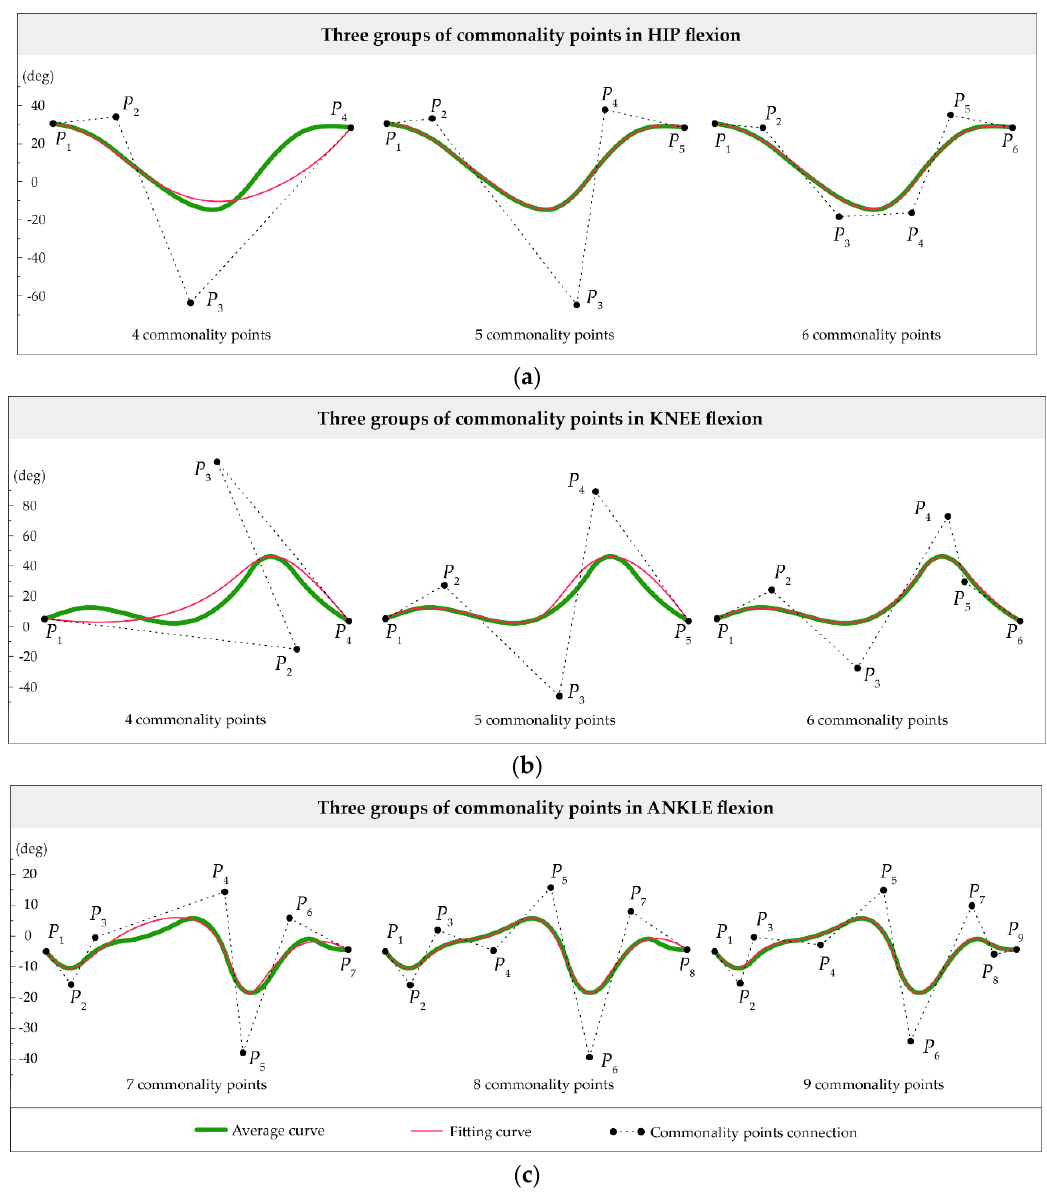
Figure 5. The fitting curves of three groups of commonality points to each joint: ( a ) The average curve (dark green line) of the hip was fitted through four, five, and six commonality points, respectively. The fitting curve (red line) at five points had the similar matching effect as six points, but with fewer points; ( b ) The three relationships among the fitting and average curves at four, five, and six points of the knee joint; ( c ) The average ankle joint curves were fitted by seven, eight, and nine commonality points. Table 1. The three groups of curve fitting results of joints.